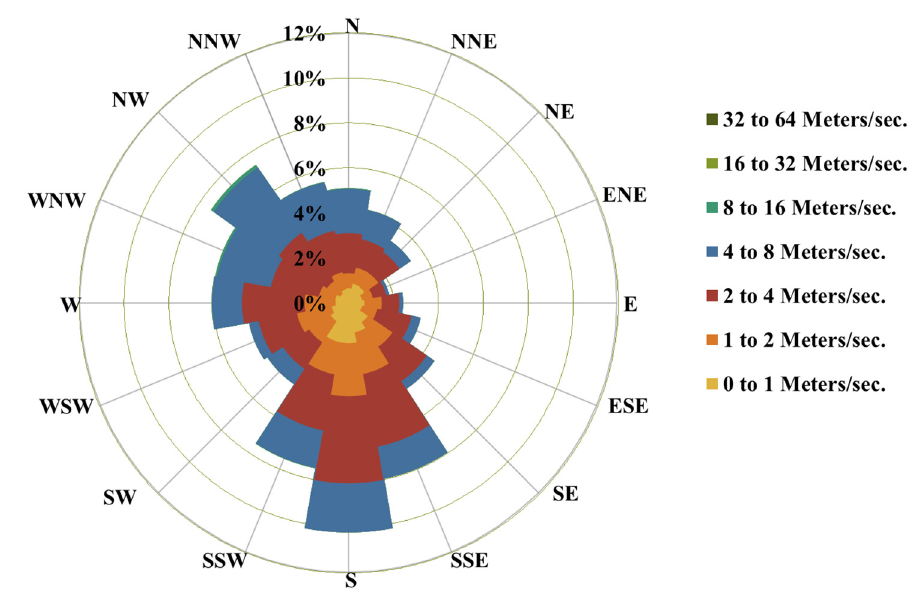
Figure 8. DD Mine wind rose, October 2012–December